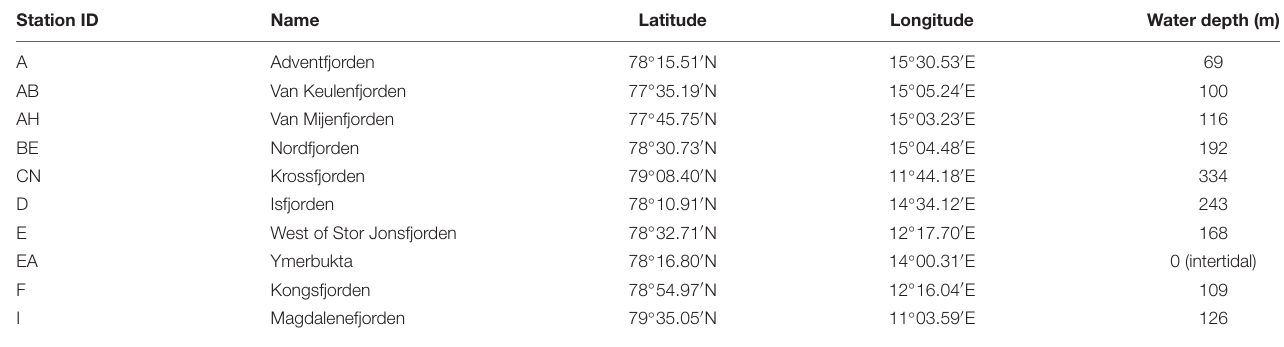
TABLE 1 | Sediment sampling stations, geographic coordinates, and water